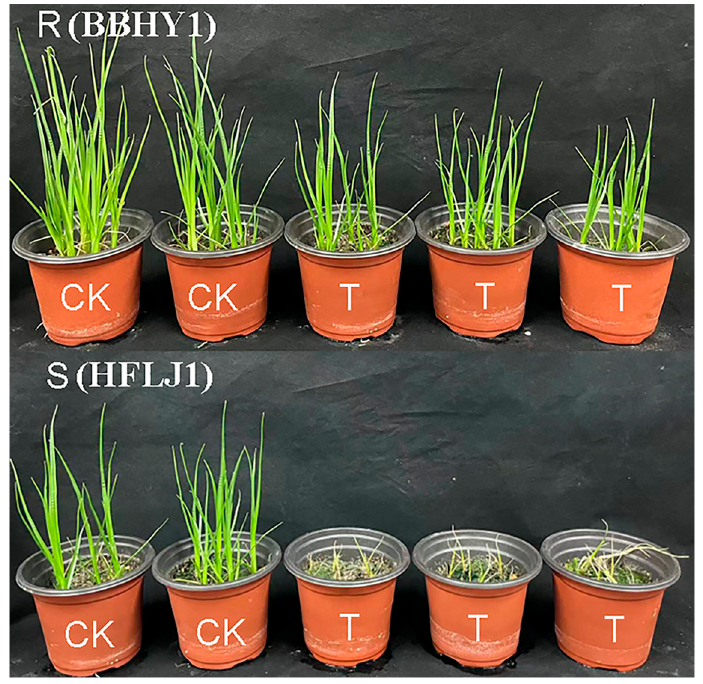
Figure 1. The R (BBHY1) and S (HFLJ1) biotype plants 21 days after FRR doses of bensulfuron-methyl treatments, showing untreated (CK) and bensulfuron-methyl treatment (T).